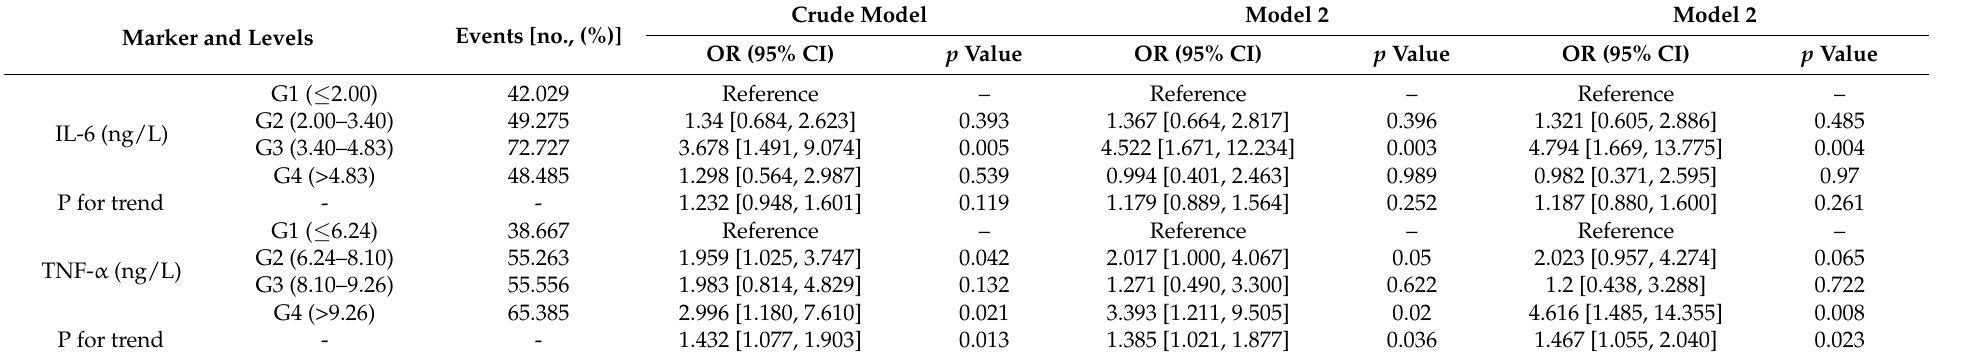
Table 2. Association of inflammatory markers IL-6 and TNF- α with postoperative modified Rankin Scale score ≥ 2. Marker and